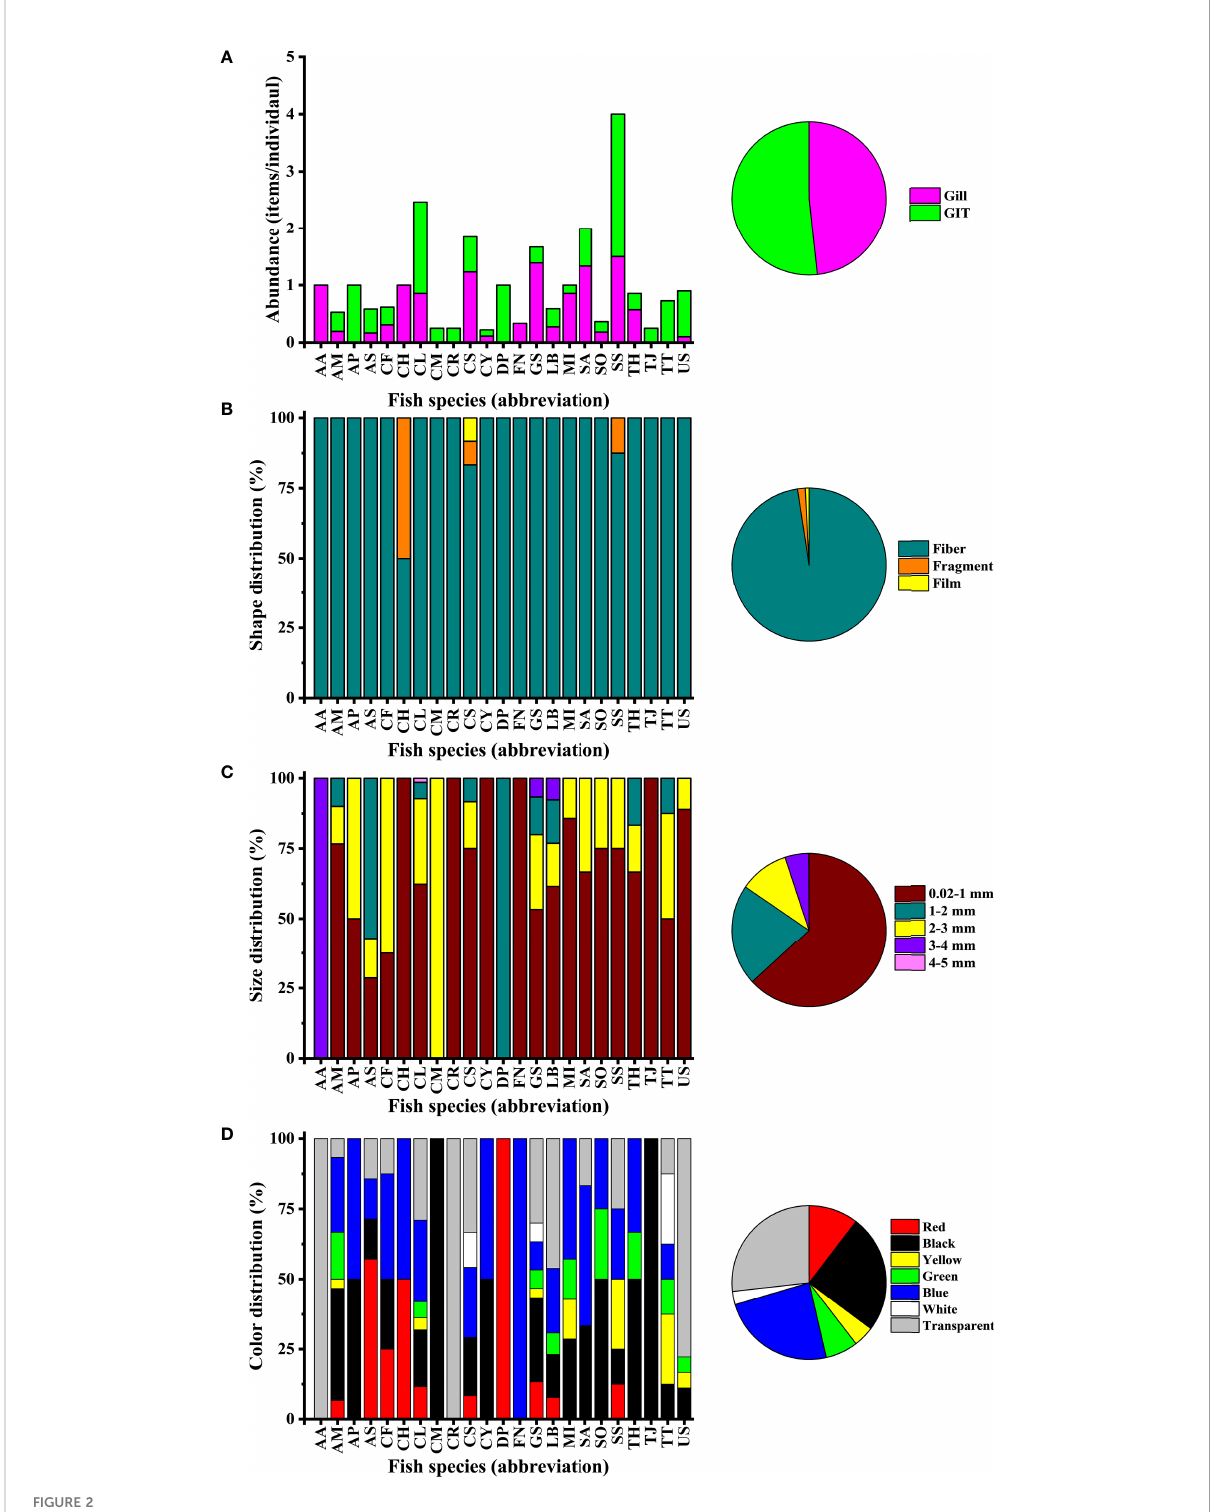
FIGURE 2 The abundances (A) , shapes (B) , sizes (C) , and colors (D) of microplastics detected in marine fi shes from Beibu Gulf (for the species abbreviations, refer to Supplementary Table S1